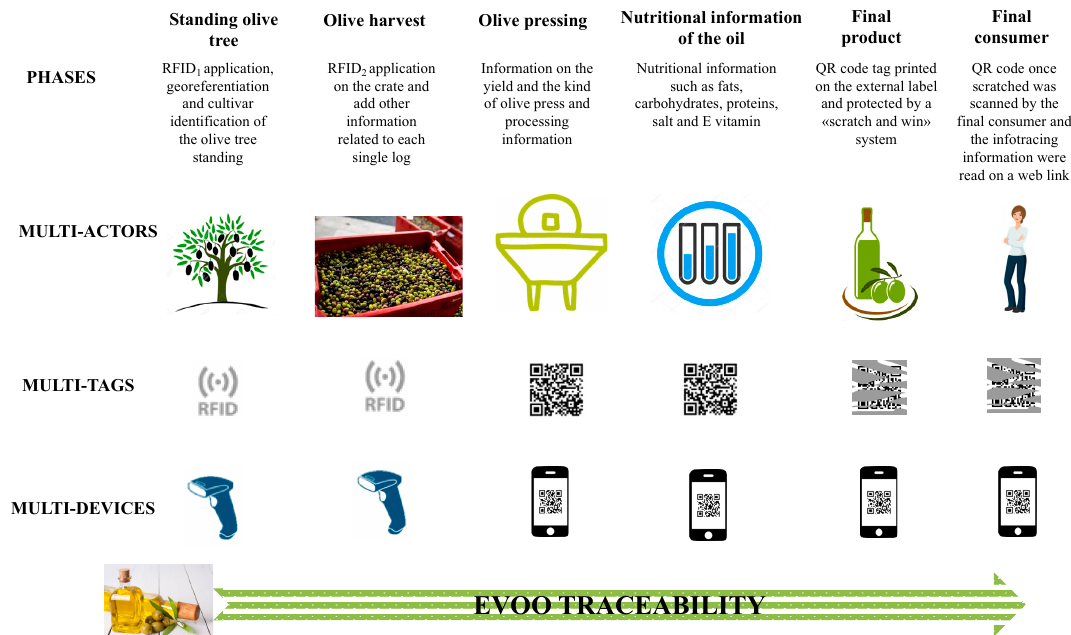
Figure 1. Extra virgin olive oil (EVOO) traceability scheme and phases including relative multi-actors, multi-tags and multi-devices. The standing olive tree phase included application of the first radio frequency identification (RFID1); cultivar identification; first tag association and information storage in the database. During the olive harvesting the second RFID (RFID2) was applied on the crate, and other information related to each crate were added. During olive pressing, the information related to processing and yield were added. The nutritional information of the olive oil related to fats, carbohydrates, etc., was assessed and stored On the final product was printed and applied to the bottle a label with a QR code tag protected by a “scratch and win” system. Finally, once scratched, the QR code was scanned by consumers, and the information tracked by the infotracing system was read on the web through a dedicated link that was generated.